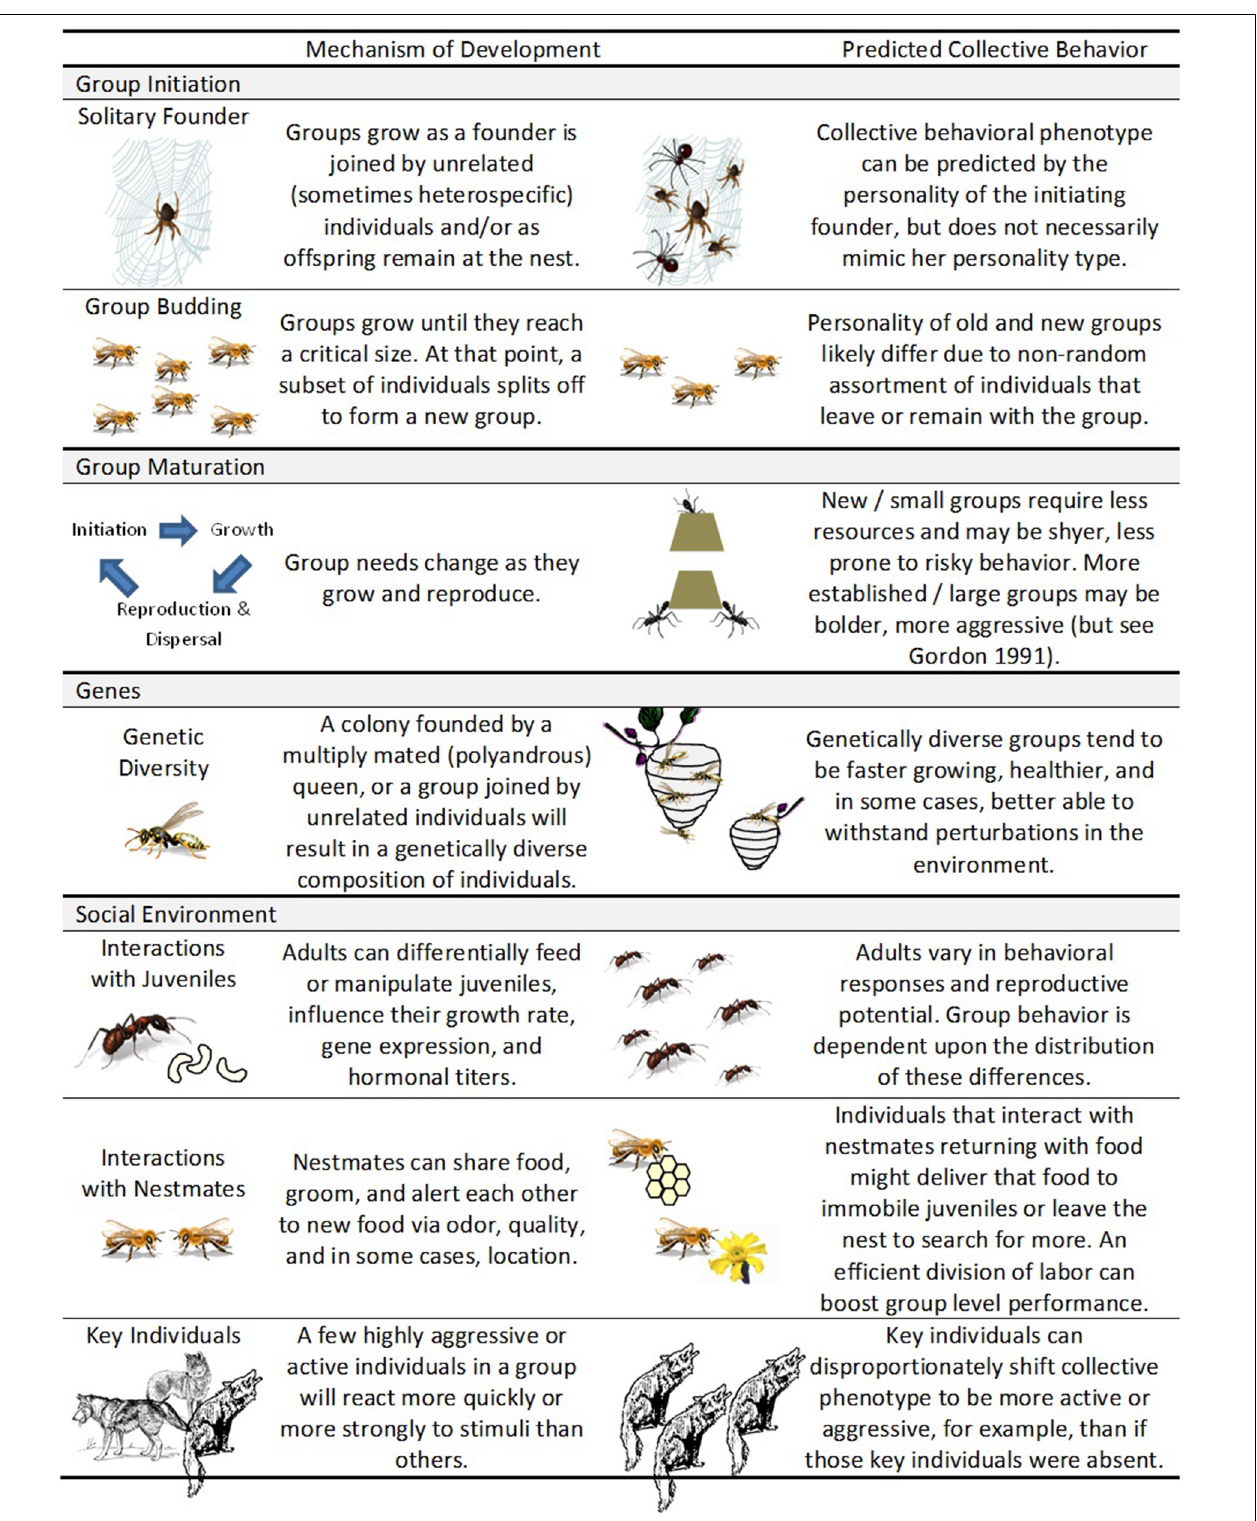
FIGURE 2 | Development of collective personalities. Collective personality development can manifest itself in multiple ways—through group initiation, group maturation, genes, and social environment.